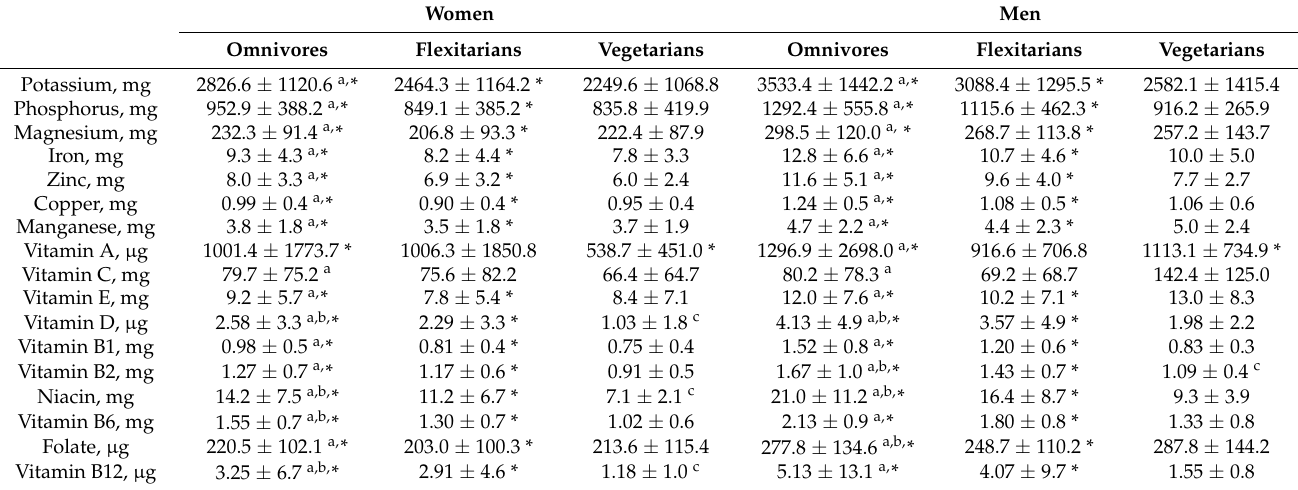
Table 4. Daily intake of selected micronutrients, including antioxidants, according to the dietary pattern. Women Men Omnivores Vegetarians Omnivores Vegetarians